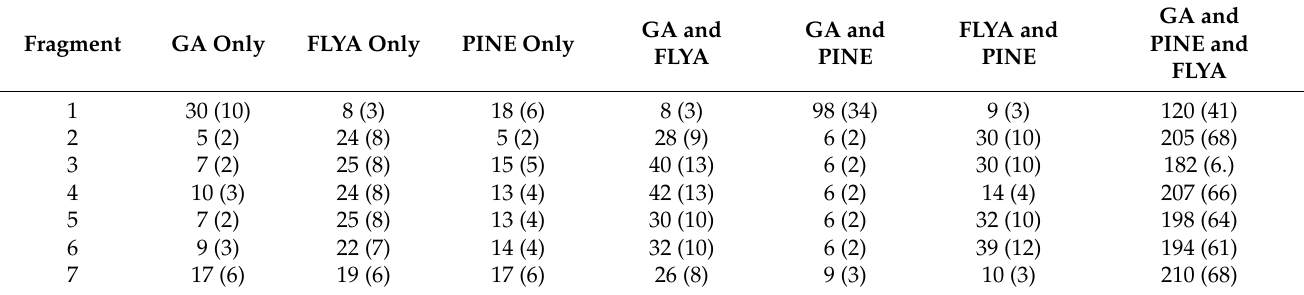
Table 5. Mutual agreement of correct chemical shift assignments for Fes SH2 among different algorithms. 1.